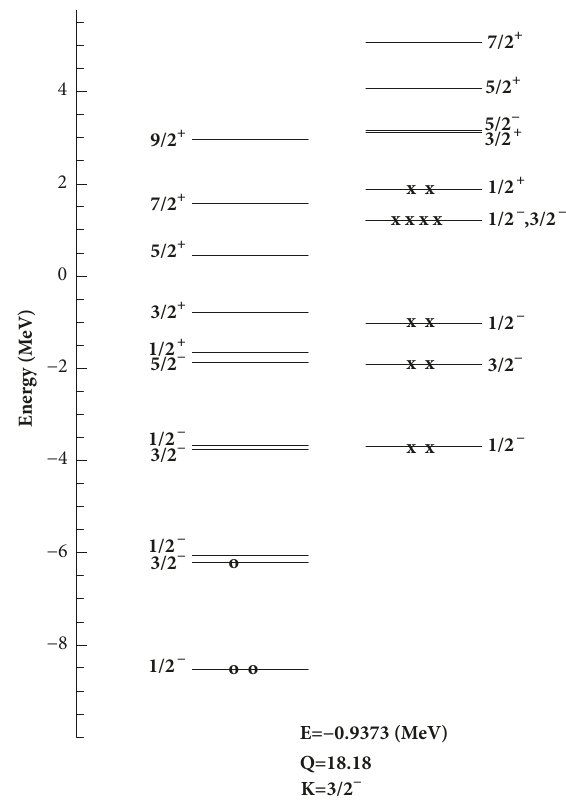
Figure 2: HF single-particle spectra for 71 Ga corresponding to the lowest prolate configuration. In the figure, circles represent protons and crosses represent neutrons. The HF energy 𝐸 in MeV, the mass quadrupole moment Q in units of the square of the oscillator length parameter, and the total azimuthal quantum number 𝐾 are given in the